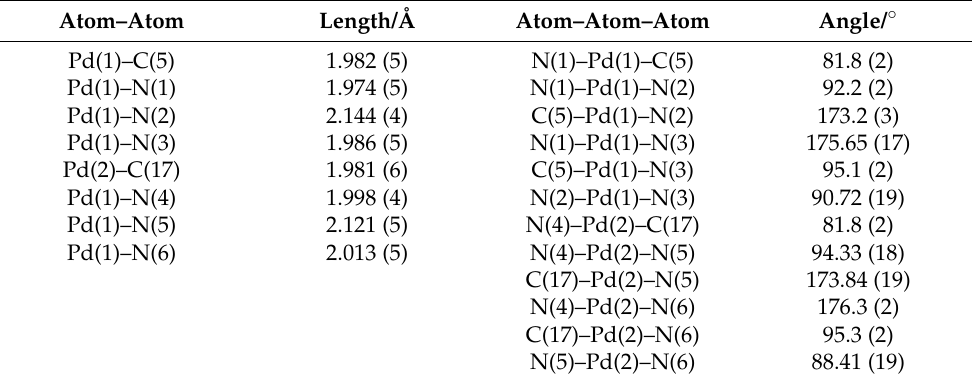
Table 3. Selected bond parameters for 2 .